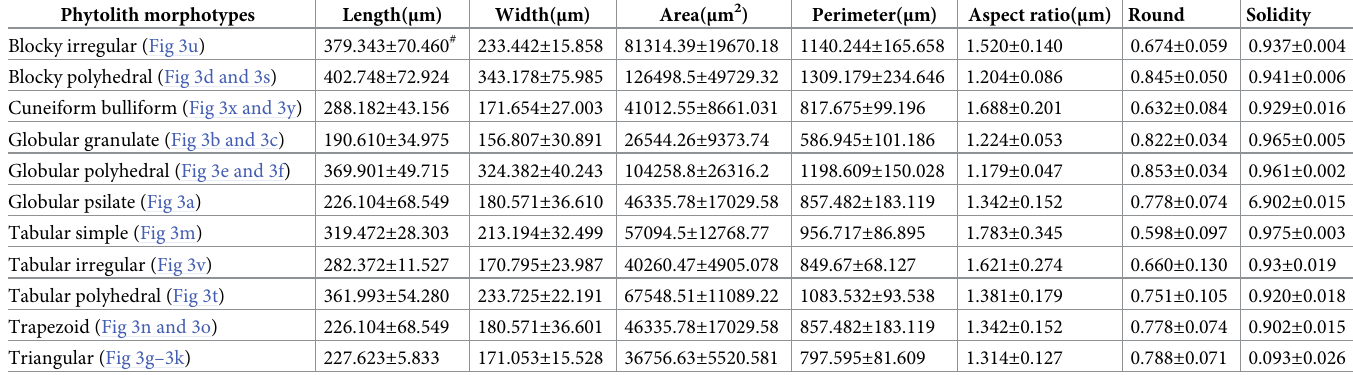
Table 2. Morphometry of phytolith morphotypes of Acrachne racemosa (Heyne ex Roem. & Schult.) Ohwi (Root). Phytolith